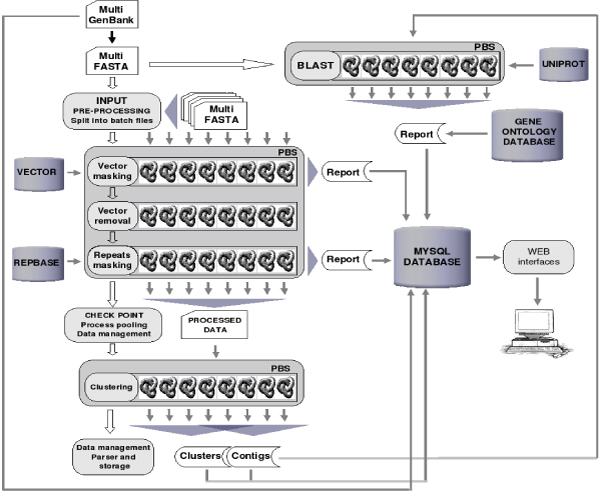
Schematic view of ParPEST pipeline. EST sequences in GenBank or FASTA format can be submitted to the pipeline. ParPEST performs automatically the consecutive processes (ESTS cleaning, clustering, assembling and BLAST comparisons) as represented by blank arrows (⇒). Data flow is represented by simple arrows (→). Databases supporting the analysis are included. The results are adequately reported and organized into a MySQL relational database indicated too. As reported, the database can be queried by SQL calls and is accessible to users by web based intuitive interfaces.